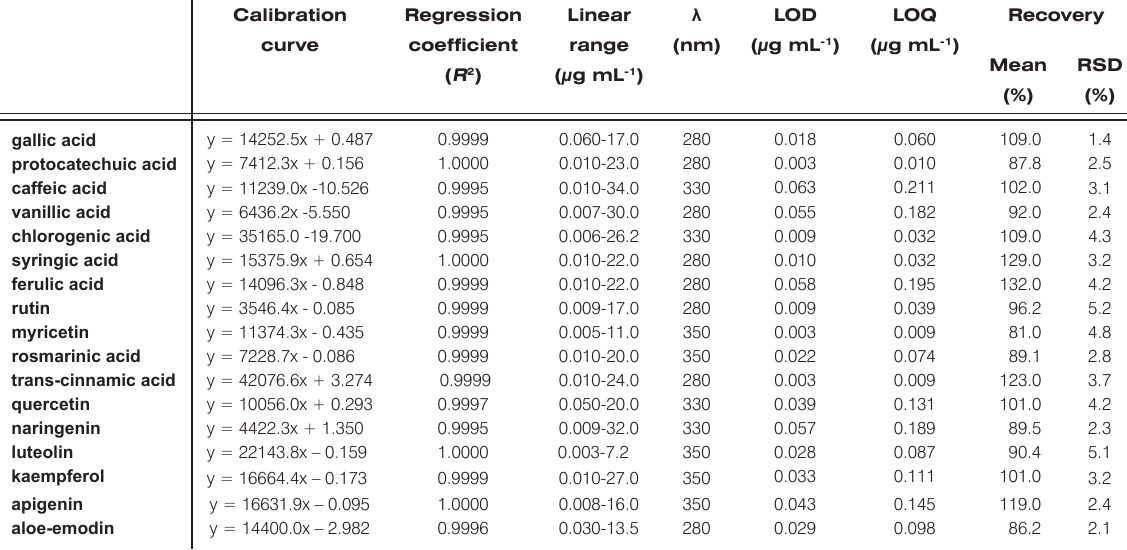
Table 1. Calibration curves, linearity ranges, LODs, LOQs and recoveries of external standards. Calibration curve